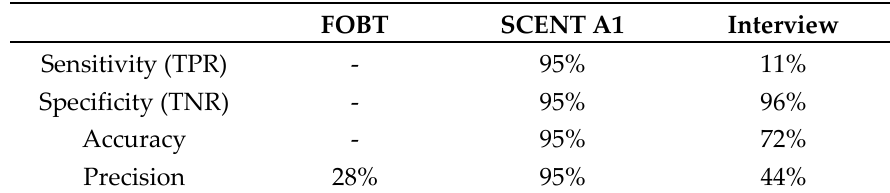
Table 2. Comparison of FOBT with the SCENT A1 data of feasibility study and patients’ health evaluation during the interview. Samples are all from patients resulted positive to FOBT, so it is possible to estimate only the precision for this test. Data coming from the clinical validation of SCENT A1 are not shown due to the fact that they are split in three